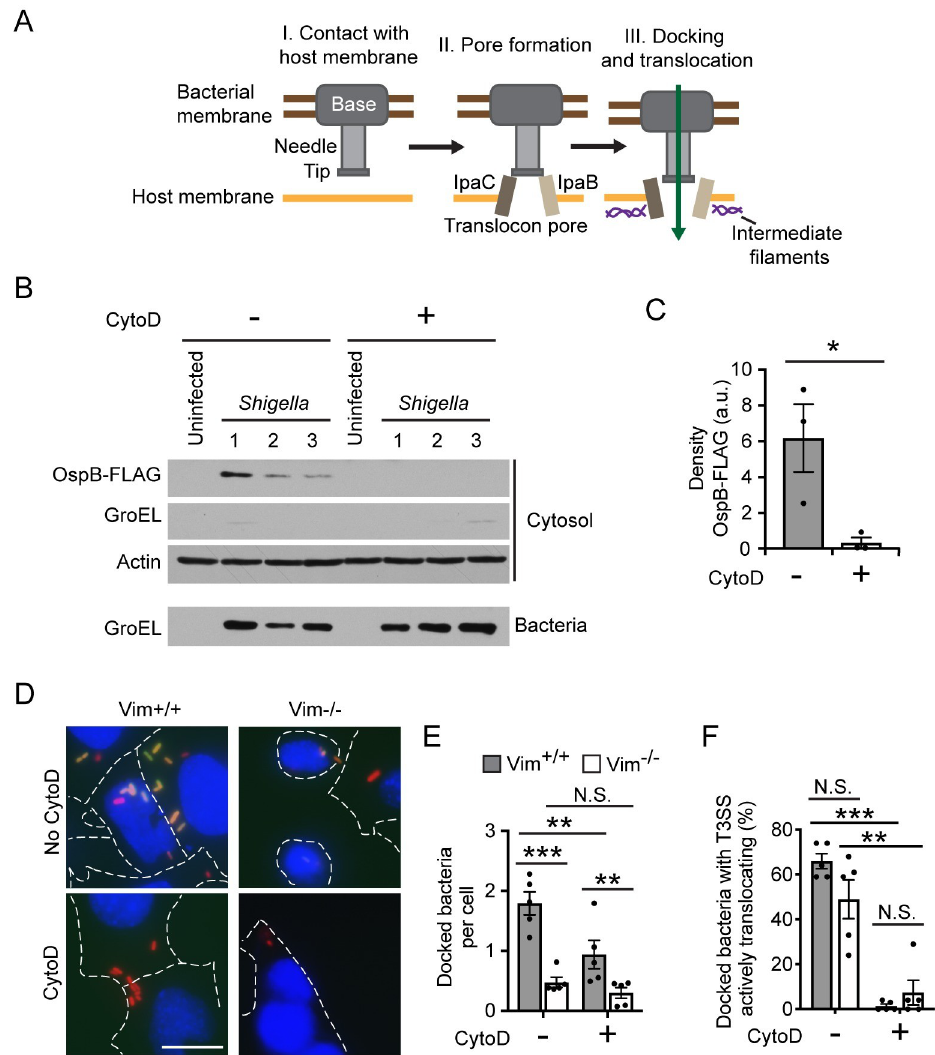
Fig 1. Type 3 effector translocation requires actin polymerization. (A) Schematic depiction of stages of type 3 secretion. Transient contact with the host plasma membrane (I) induces the secretion of the translocon pore proteins and their assembly into translocon pores in the host membrane (II). Interaction of the translocon pore protein IpaC with intermediate filaments alters the conformation of the translocon pore (III), which enables bacterial docking and effector protein secretion. (B-C) Effect of CytoD on translocation of FLAG-tagged type 3 effector OspB. S . flexneri infection of HeLa cells at a MOI of 200 in the presence or absence of CytoD. (B) Representative western blots. OspB-FLAG, FLAG-tagged effector protein; GroEL, bacterial cytosolic protein; actin, eukaryotic cytosolic protein. All panels are from the same experiment, numbers indicate independent wells from the same experiment. (C) Quantification of FLAG-tagged OspB in experiments represented in panel B. Data points are independent experiments. (D-F) Effect of CytoD on the efficiency of docking and activation of T3SS translocation. S . flexneri infection of Vim +/+ or Vim -/- MEFs at a MOI of 200 in the presence or absence of CytoD. (D) Representative images at 50 minutes of infection. Blue, Hoechst (DNA); red, mCherry (constitutively produced by bacteria); green, GFP (transcriptionally induced in bacteria by the secretion of the type 3 effector OspD). Dotted white lines, cell boundaries; scale bar, 20 μ m. (E) Quantification of docked bacteria per cell from three independent experiments represented in panel D. (F) Percentage of docked bacteria that activate TSAR in experiments represented in panel D. (C) Student’s t- test. (E-F) two-way ANOVA with Tukey post hoc test. (C, E-F) � , p < 0.05; �� , p < 0.01; ��� , p < 0.001; data are the mean ± SEM of three to five independent experiments.